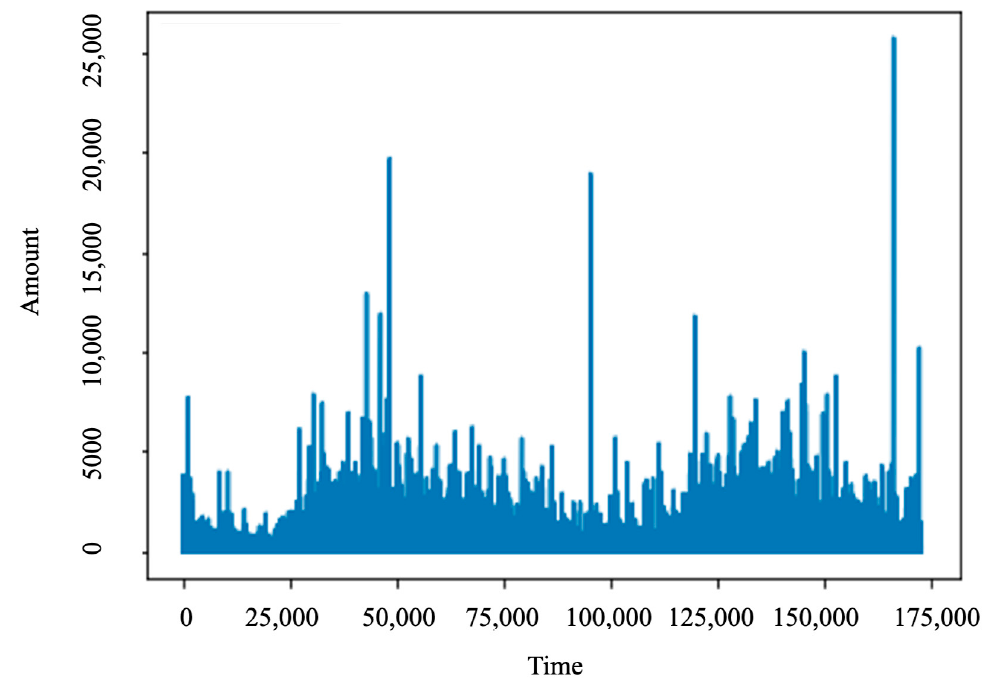
Figure 3. Plot Amount